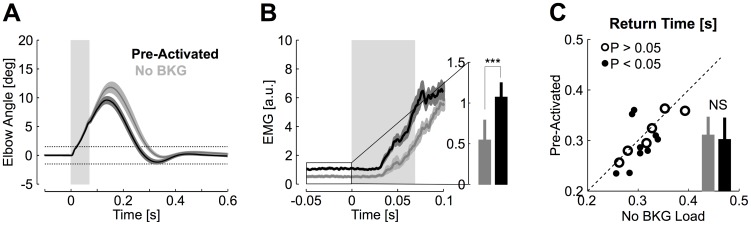
Effect of muscle pre-loading on return times.A: Group averages of elbow motion in the 300 ms condition, with (black) or without (gray) application of a background load. The gray rectangle illustrates the onset and offset of the square perturbation pulse. The horizontal dotted lines represent the 3 deg virtual target. Shaded areas represent 1 SEM B: Muscles grand average across subjects (mean ± SEM). The inset displays the pre-perturbation activity (−50 to 0 ms) with the same color code as in panel A (1 bar represent one standard deviation). The statistical difference across conditions is illustrated (see Results). C: Return times in the 300 ms condition without background load, plotted against the return times obtained after pre-loading the muscles. Filled dots illustrate significant differences from individual trials based on Wilcoxon ranksum tests. Open dots are displayed otherwise. Summary of group average and standard deviation is presented in the bar graph.